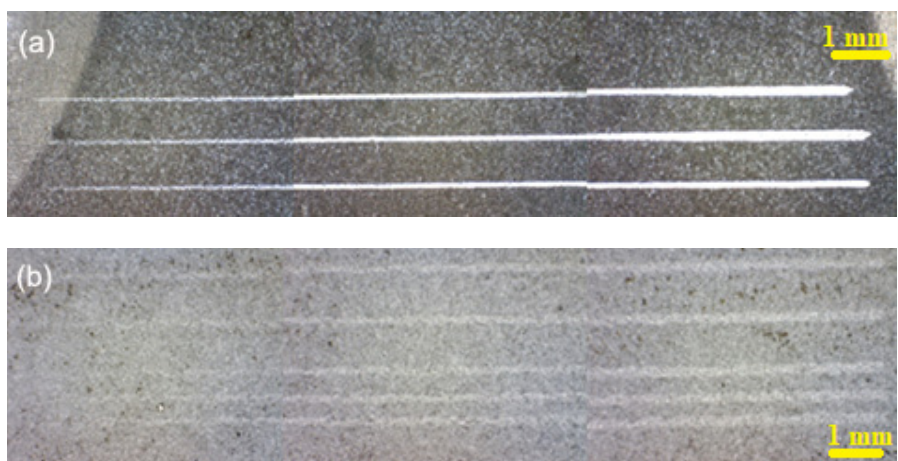
Figure 4. Identification and images of scratches using optical microscopy for the coatings: ( a ) two layers; ( b ) four layers.